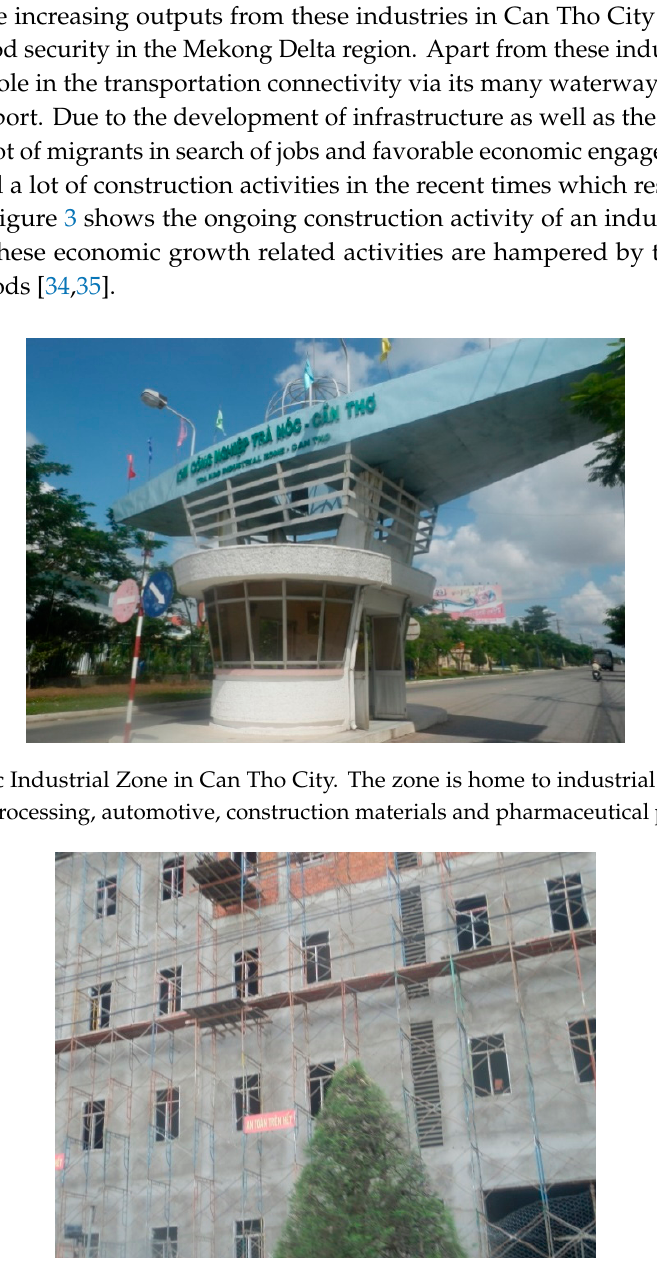
Figure 3. An industrial building under construction in Can Tho City.